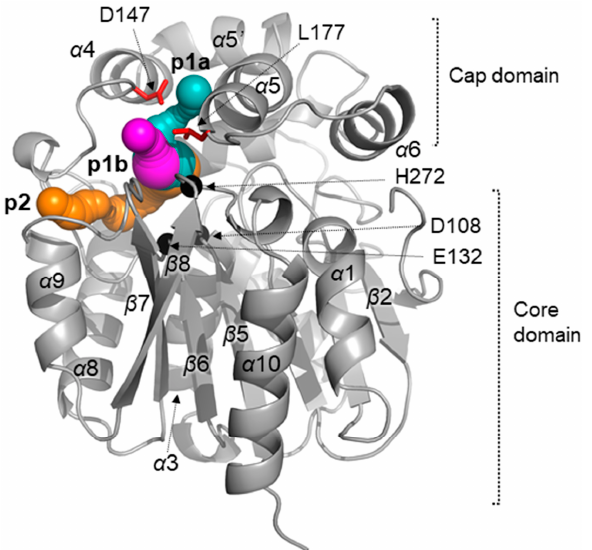
Figure 1. Overall structure of the wild type LinB dehalogenase (PDB ID 1cv2, [5]). The upper, lower tunnels and slot are shown as magenta, cyan and orange spheres, respectively. The catalytic triad residues (Asp108, Glu132 and His272) are shown as black spheres. The studied mutations are shown as red sticks.